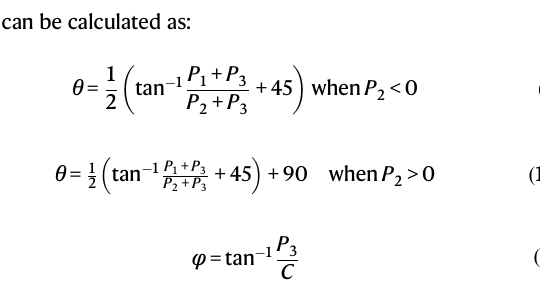
oftheobjectwithtextpatternNTUandEEE. b – e MeasuredImagingresultsofthree ports (Port 1, Port 2, and Port 3), and calculated imaging results of AoLP and DoCP under linear polarized (( b ) LP-45° and ( c ) LP-135°) and circular polarized (( d ) LCP and ( e ) RCP) light